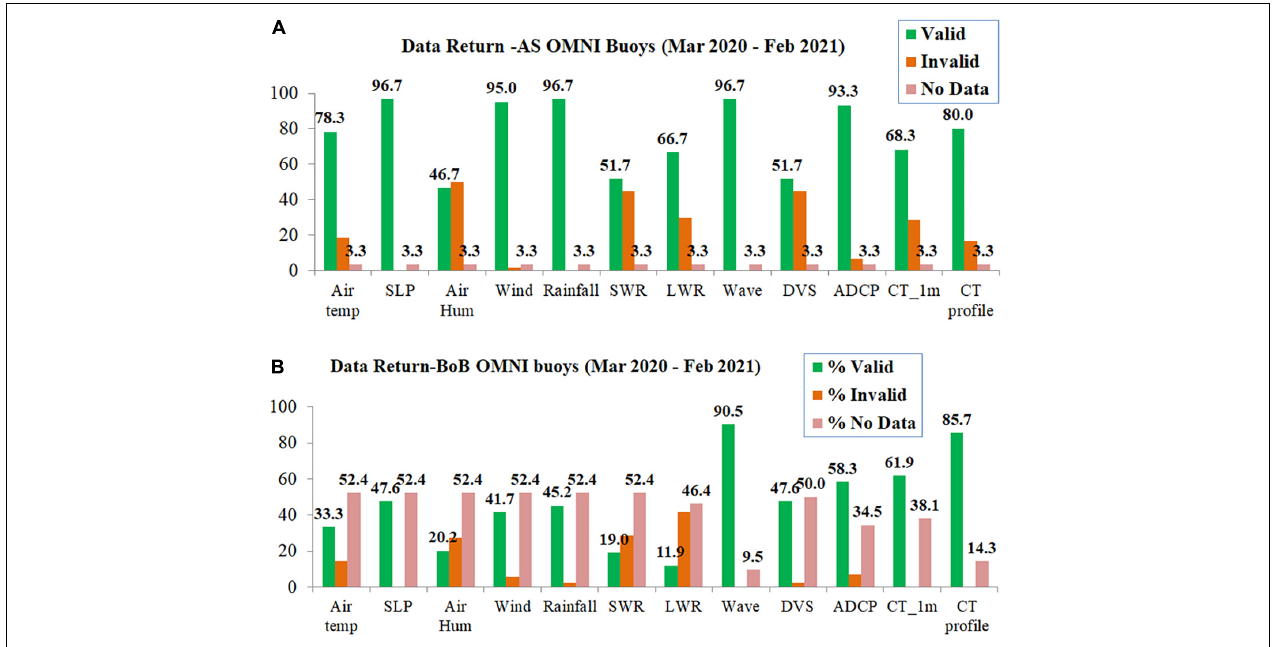
FIGURE 5 | The percentage of data return (A) in AS and (B) in BoB after the preliminary quality analysis during the period March 2020–February 2021.